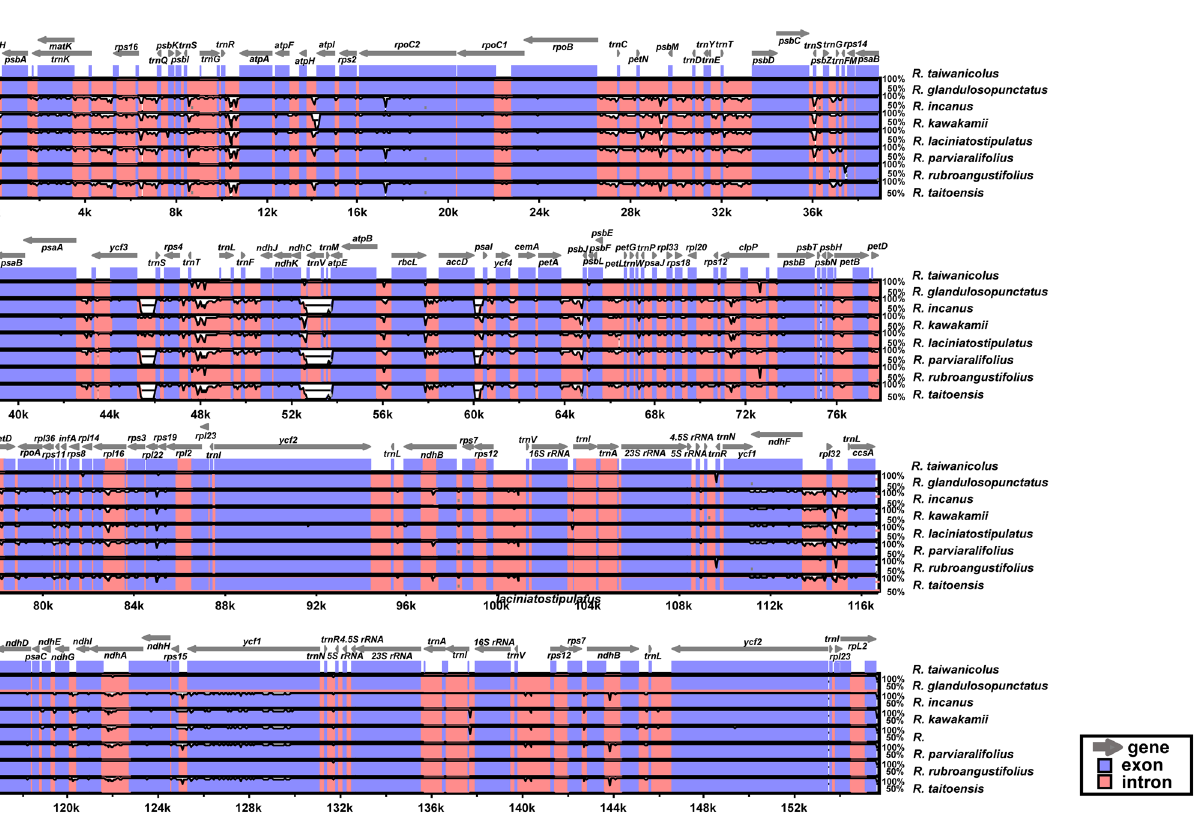
Figure 4. Visualization of alignment of eight Rubus species chloroplast genome sequences. The VISTA-based identity plots using mVISTA in Shuffle-LAGAN (LAGAN toolkit version 2.0; http://lagan .stanf ord.edu/gloca l) show the sequence identity of eight Taiwan endemic Rubus species. Vertical scale indicates the percent identity from 50 to 100%. Coding and non-coding regions are in blue and pink, respectively. Gray arrows above the alignment indicate the position and direction of each